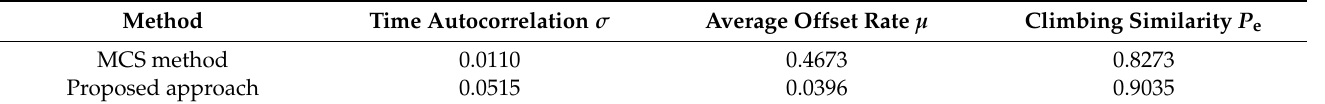
Table 6. Results of evaluation indexes.